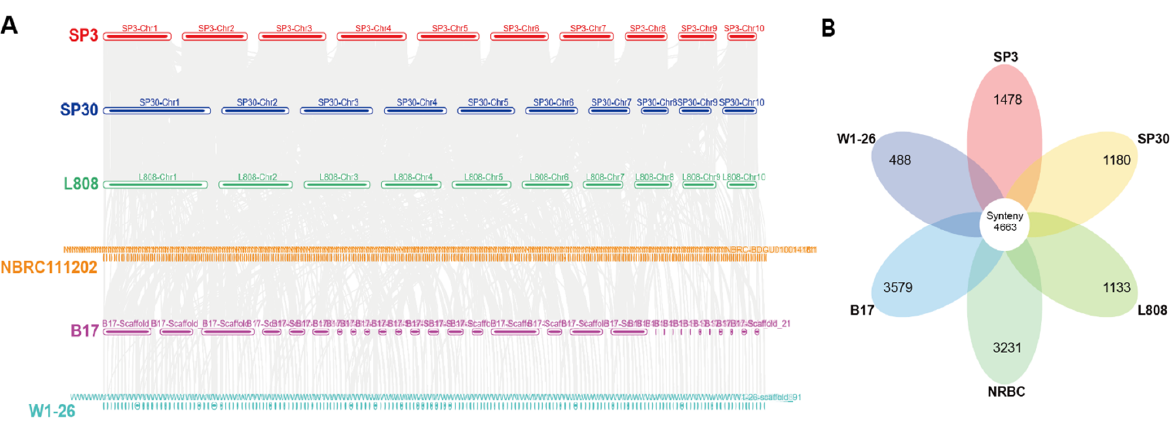
Figure 2 . Collinearity analysis between the two monokaryotic genomes in a dikaryotic cultivar of Lentinula edodes . ( A ) Collinearity analysis between SP3 and SP30 genomes and the published genomes of L. edodes strains L808, NBRC111202, B17, and W1-26. ( B ) Flower diagram of core and specific genes in L. edodes genomes . The number in the center means synteny gene numbers, and numbers on the petal mean the specific gene number of each genome.